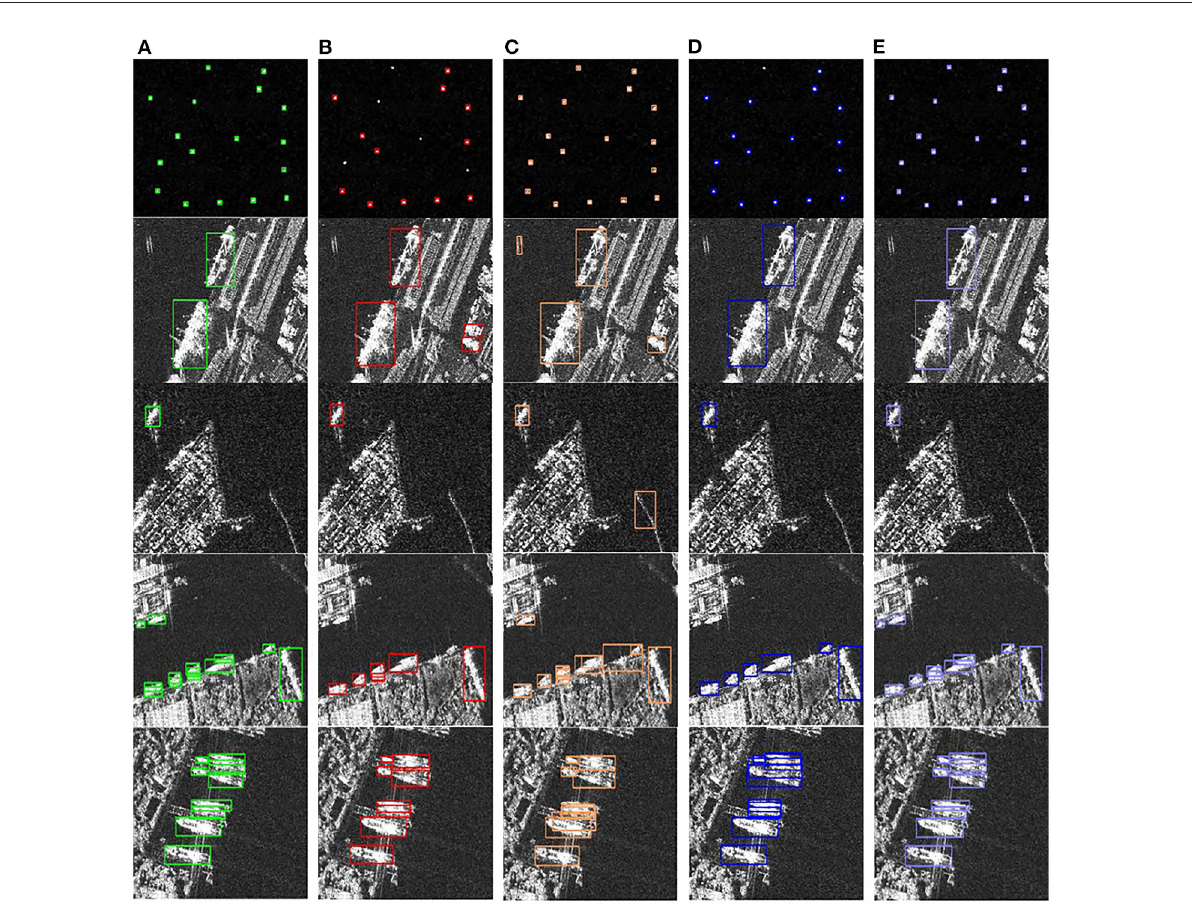
FIGURE6 Detection results of different detection methods. (A) Ground truth. (B) Detection results of Faster R-CNN. (C) Detection results of RetinaNet. (D) Detection results of VFNet. (E) Detection results of the proposed